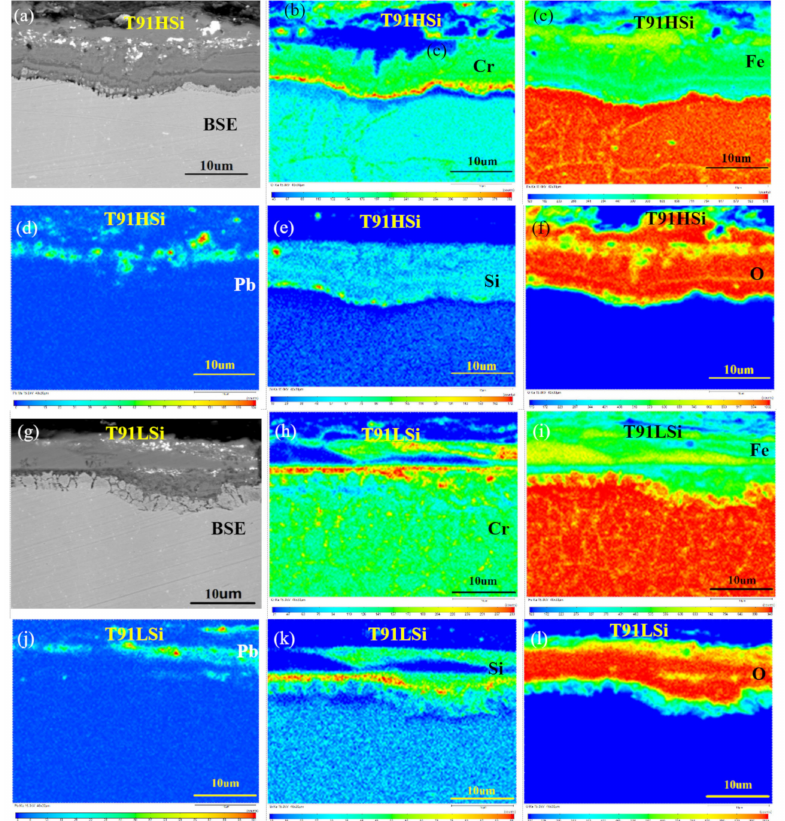
Figure 7. EPMA characterization of dynamic corrosion oxide film. ( a – f ) Composition distribution of T91HSi steel oxide film; ( g – l ) Composition distribution of T91LSi steel oxide film. The color from cold to warm indicates the component content from low to